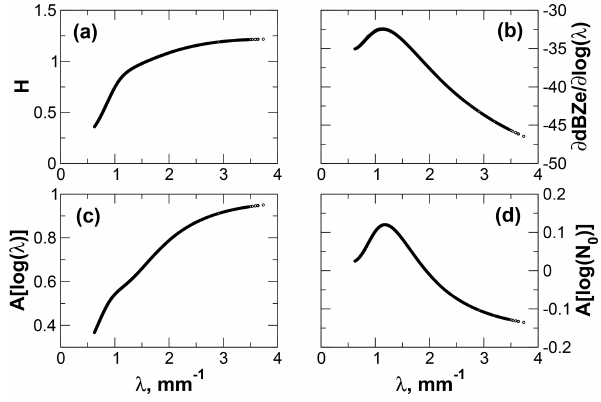
Figure 14. Information content metrics and the forward model Ja- cobian as functions of λ